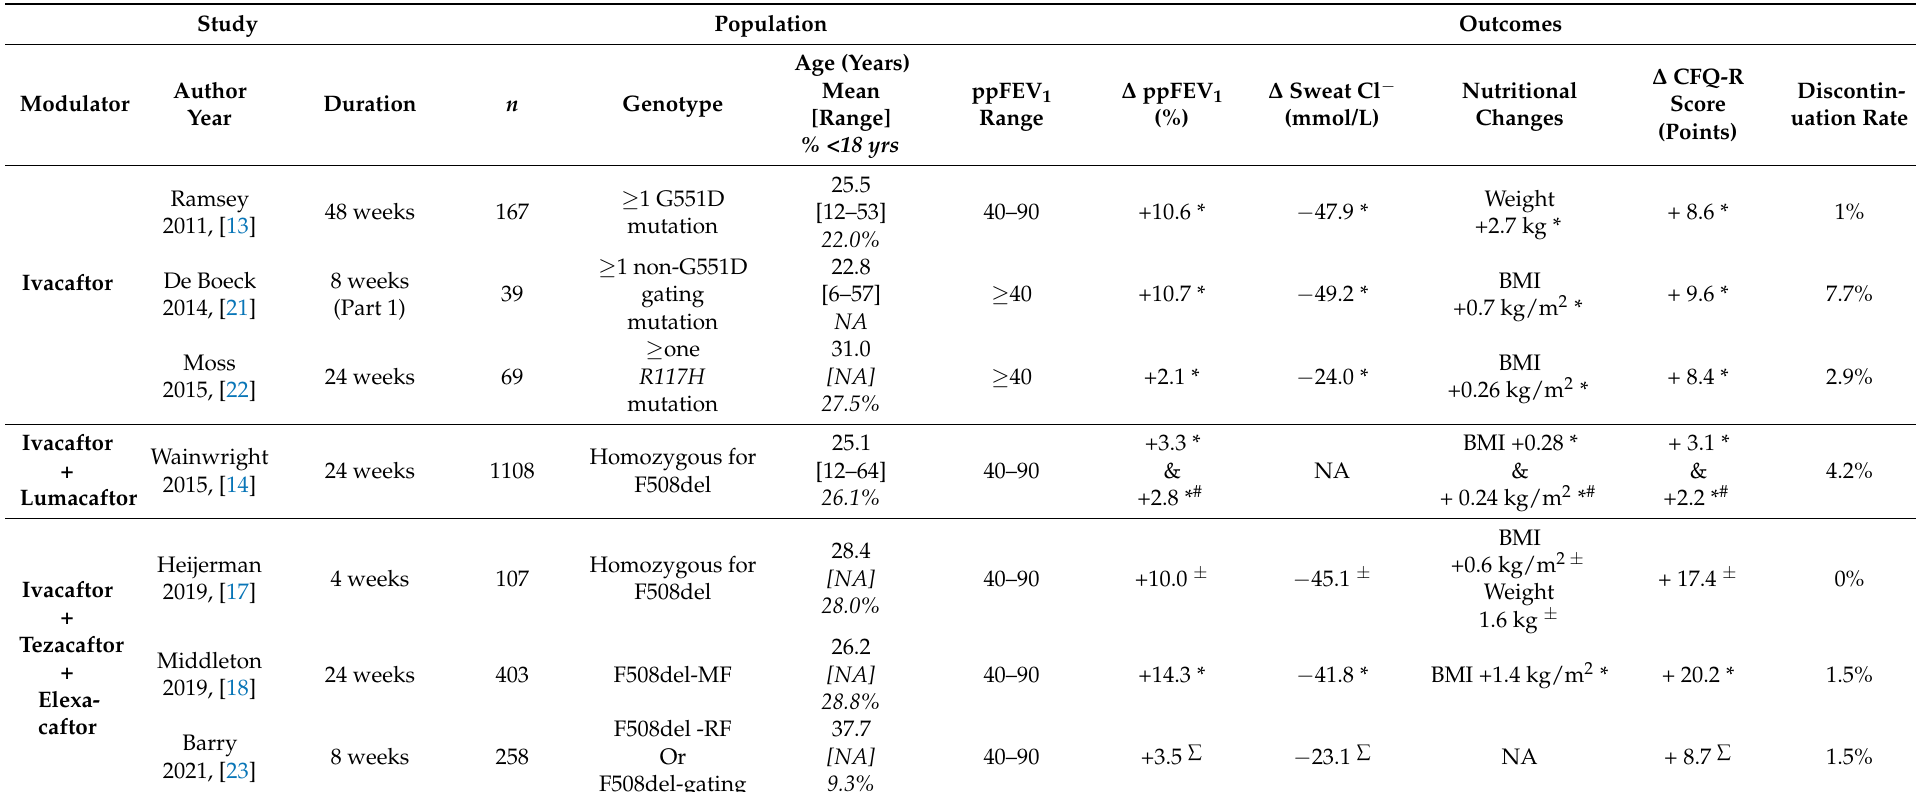
Table 2. Summary of the main phase 3 randomized controlled trials of CFTR modulators in adolescents and adults with CF. Population